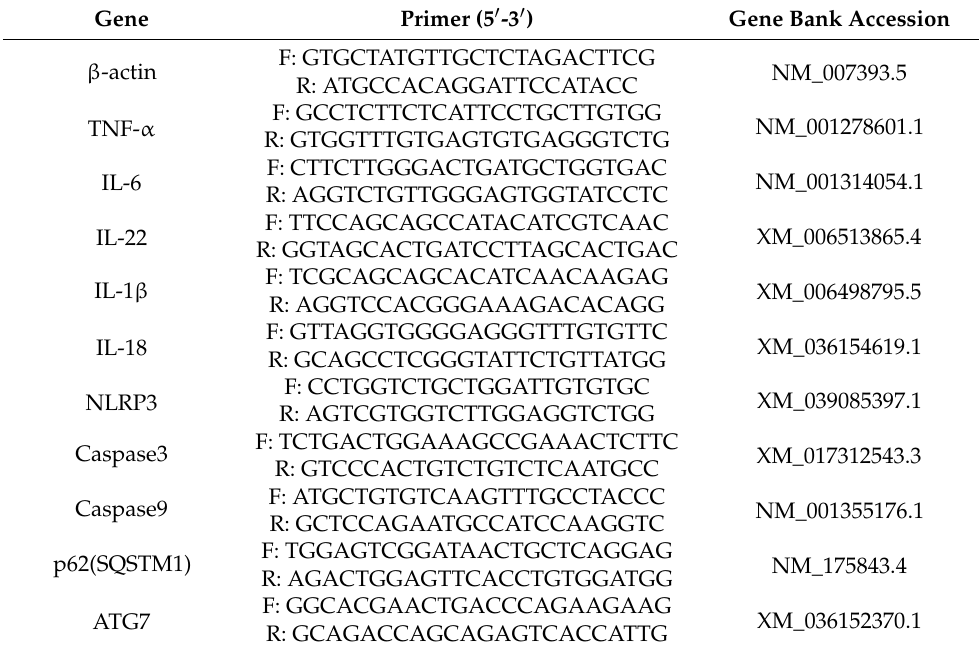
Table 1. The sequences of primers for